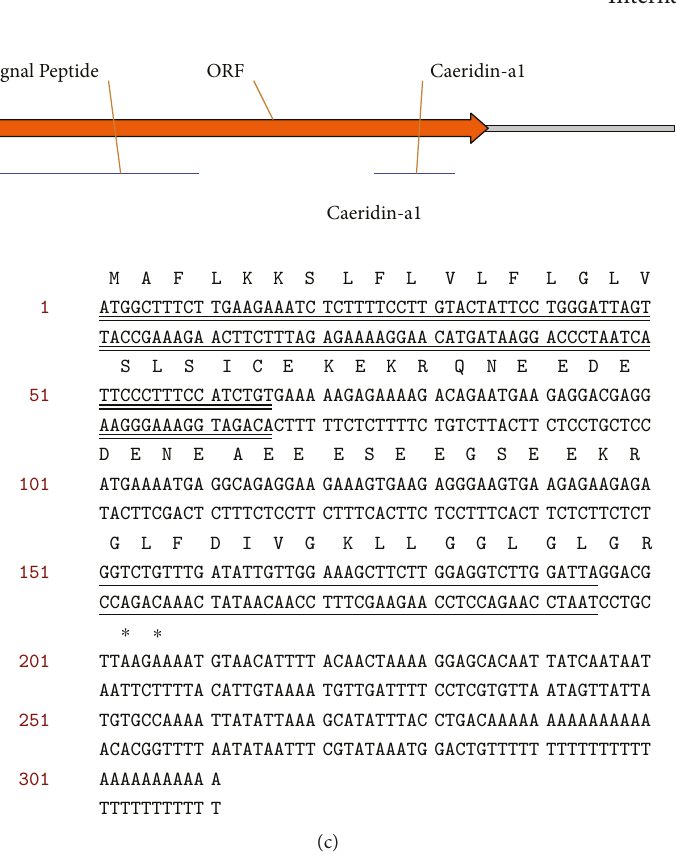
Figure 1: Nucleotide sequences of full-length cDNA clones encoding open-reading frames of (a) preprocaeridin-1, (b) preproS5-caeridin-1, and (c) preprocaerdin-a1 cloned from a Litoria caerulea ( L. caerulea ) skin secretion cDNA library. Putative signal peptide sequences are double-underlined, mature Caeridin sequences are single-underlined, and stop codons are indicated by